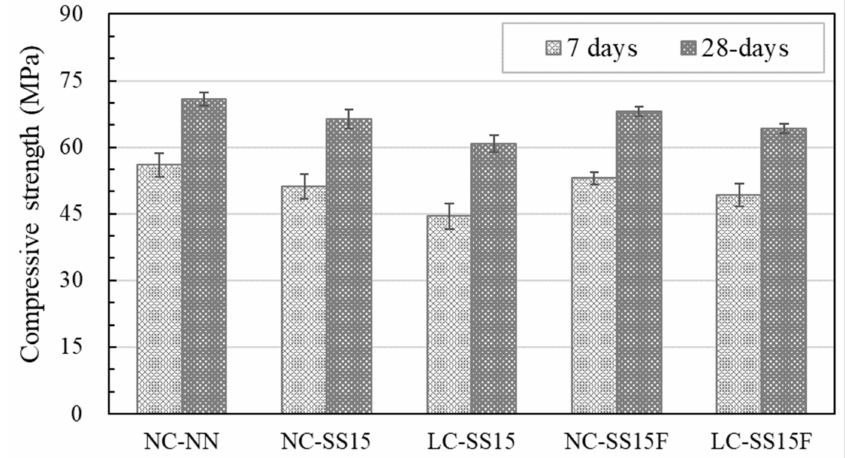
Figure 6. Compressive strength values at different curing ages.